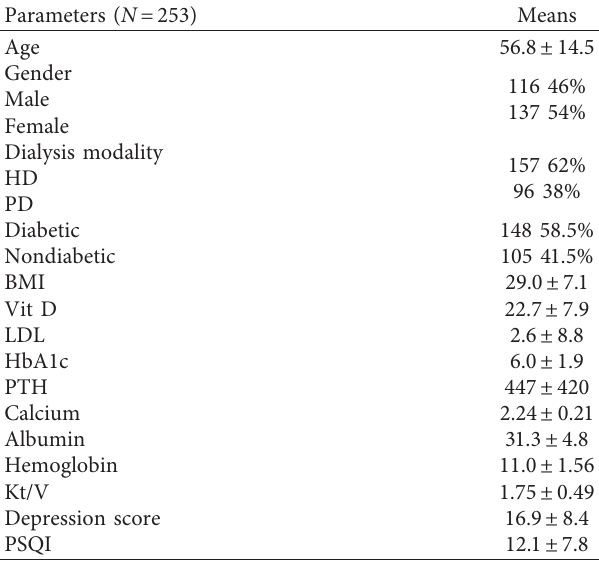
Table 1: Demographic and clinical data of the study